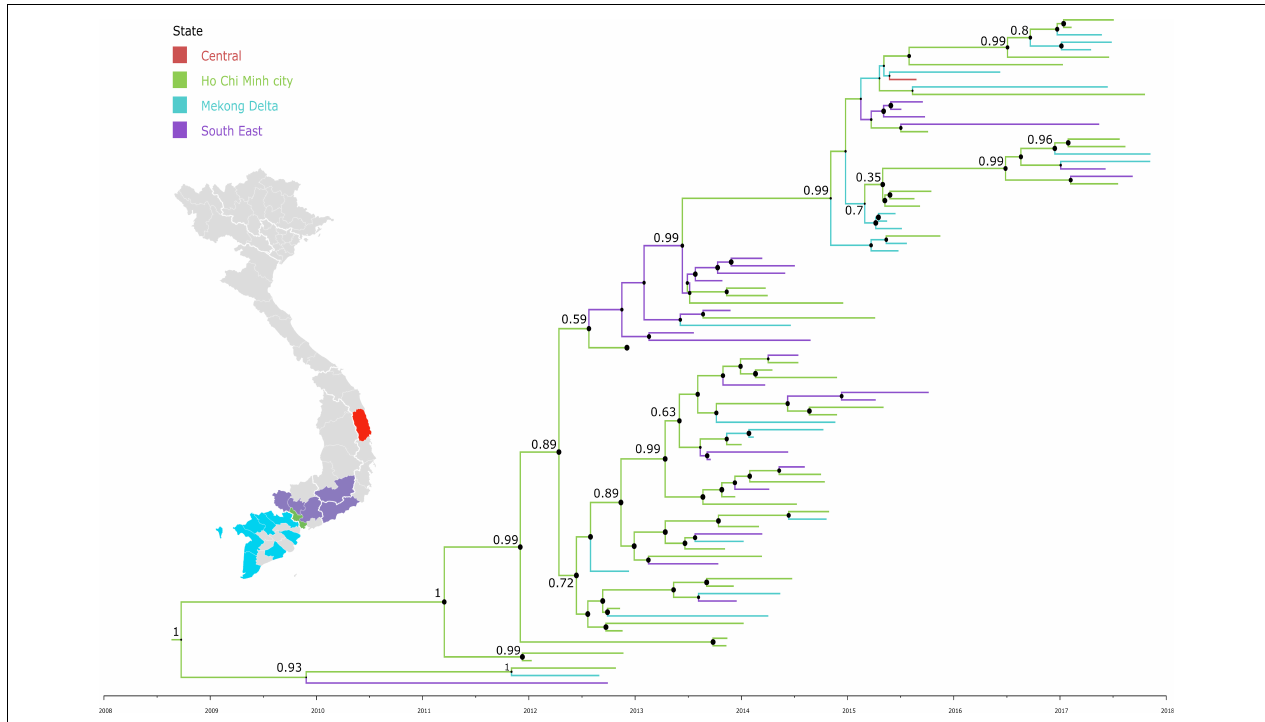
FIGURE 3 | Maximum clade credibility trees demonstrating the phylogeography of CVA16 isolates in Vietnam. The tree was constructed using VP1 sequences of Vietnamese sequences and branches are colored by regions.